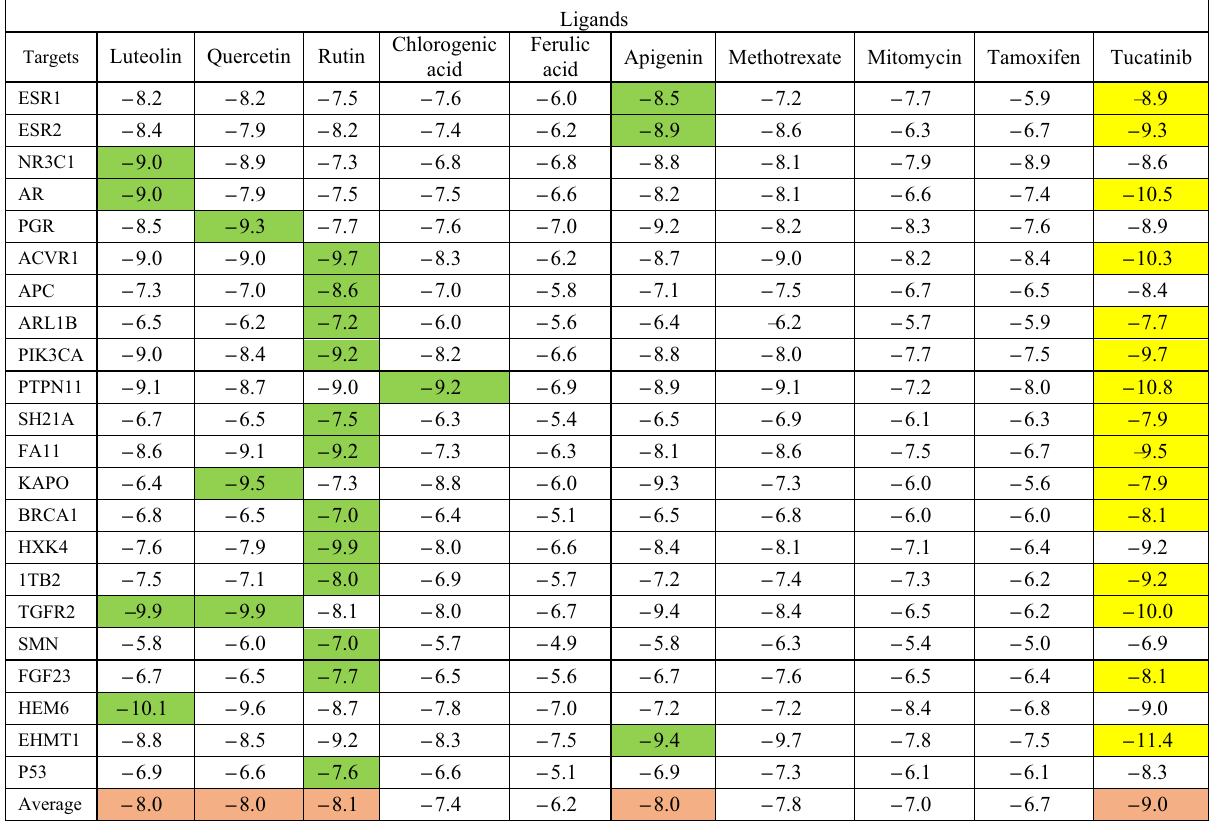
Table 2. Free energy values obtained through docking analysis.